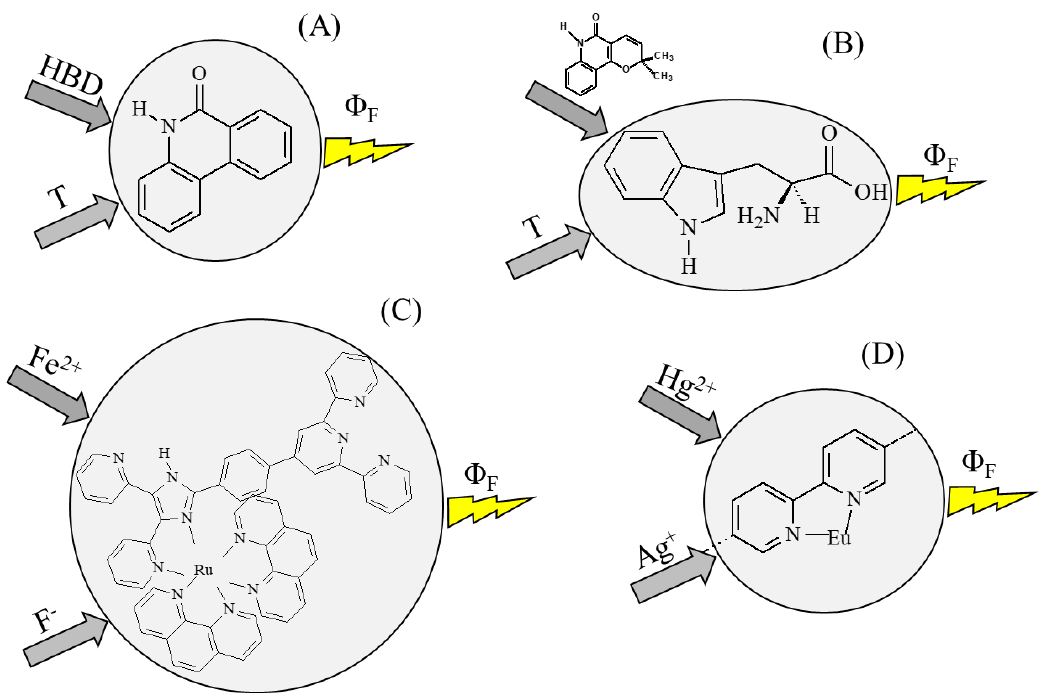
Figure 10. Dependence of the fluorescence quantum yield of 6(5 H )-phenanthridinone ( A ), tryptophan ( B ), a ruthenium complex ( C ), and europium bounded to a metal-organic framework ( D ) on physical and chemical